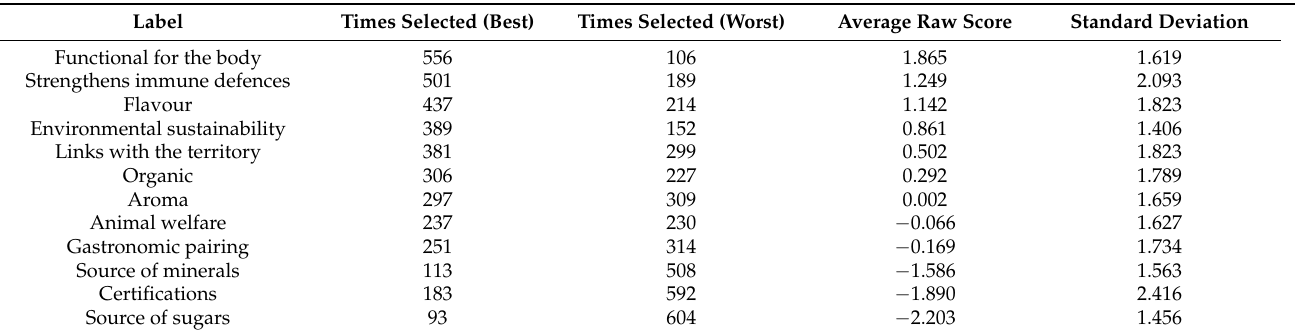
Table 3. Ranking and aggregate average importance score, and the number of times honey attributes were selected as best or